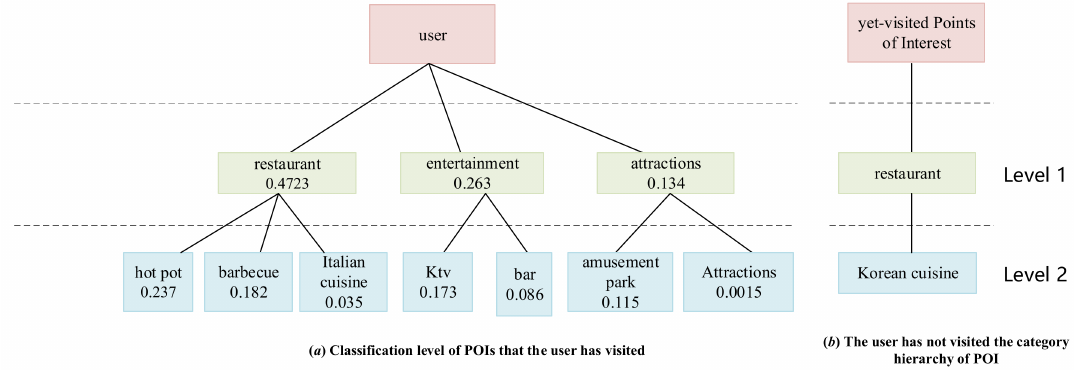
Figure 2. Example of POI Category